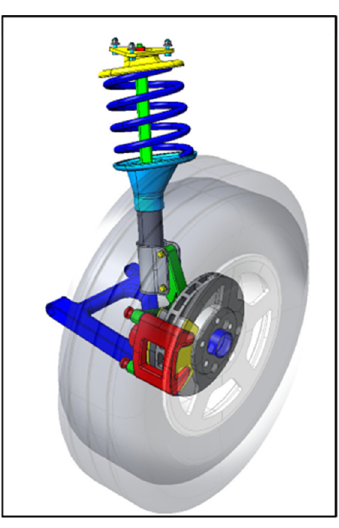
Figure 34. Pavè track. Figure 34. Pav è track.